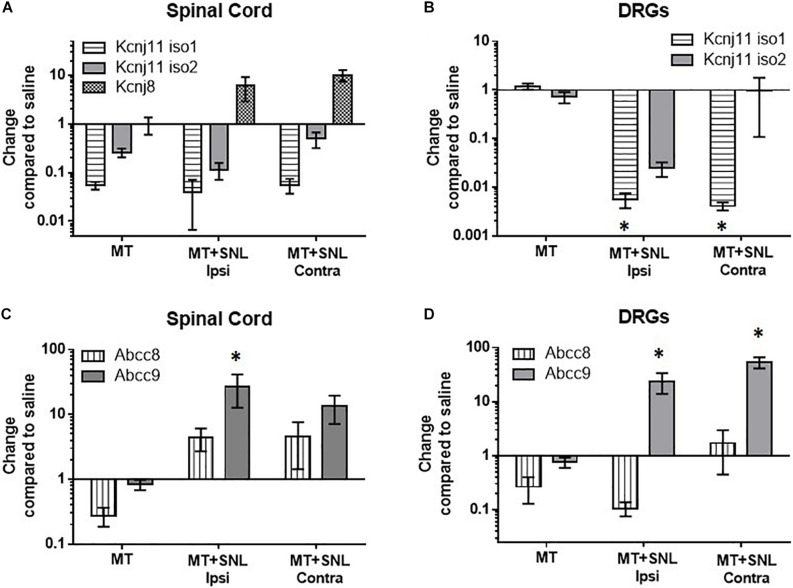
Decreased mRNA expression of Kcnj11 and increased SUR2 expression in morphine tolerant mice. Morphine tolerant (MT) mice were treated twice daily with 15 mg/kg (s.c.) morphine for 5 days. Gene expression of (MT) and morphine tolerant mice after spinal nerve ligation (MT + SNL) are compared to saline treated mice as a control. The spinal cords and dorsal root ganglia (DRG) of MT + SNL animals were compared on the ipsilateral, injured side (i.e., ipsi) as well as the contralateral, non-injured side (i.e., contra). (A) The expression of Kcnj subunits were not significantly altered in the spinal cord (n = 5–6/group). Kcnj11 iso1 potassium channel subunits were significantly decreased in the (B) dorsal root ganglia (DRG) of MT + SNL mice [two-way ANOVA, Dunnett’s post hoc compared to saline, F(3,52) = 3.8, p = 0.015, CIMT+SNL Ipsi = 0.1382 to 2.126 and CIMT+SNL Contra = 0.1367–2.127, n = 6–9/group]. (C)
Abcc9 subunit expression was significantly increased in the spinal cord compared to saline treated tissues [two-way ANOVA, Dunnett’s post hoc compared to saline, F(3,50) = 5.86, p = 0.0017; CIMT+SNL Ipsi = −40.26 to −11.66, n = 5–9/group]. (D)
Abcc9 subunit expression was also significantly increased in the DRG of MT + SNL animals [two-way ANOVA, Dunnett’s post hoc compared to saline, F(3,52) = 14.98, p < 0.001, CIMT+SNL Ipsi = −38.37 to −7.133 and CIMT+SNL Contra = −68.38 to −37.15, n = 6–9/group]. Asterisk indicates statistical significance (p < 0.05).